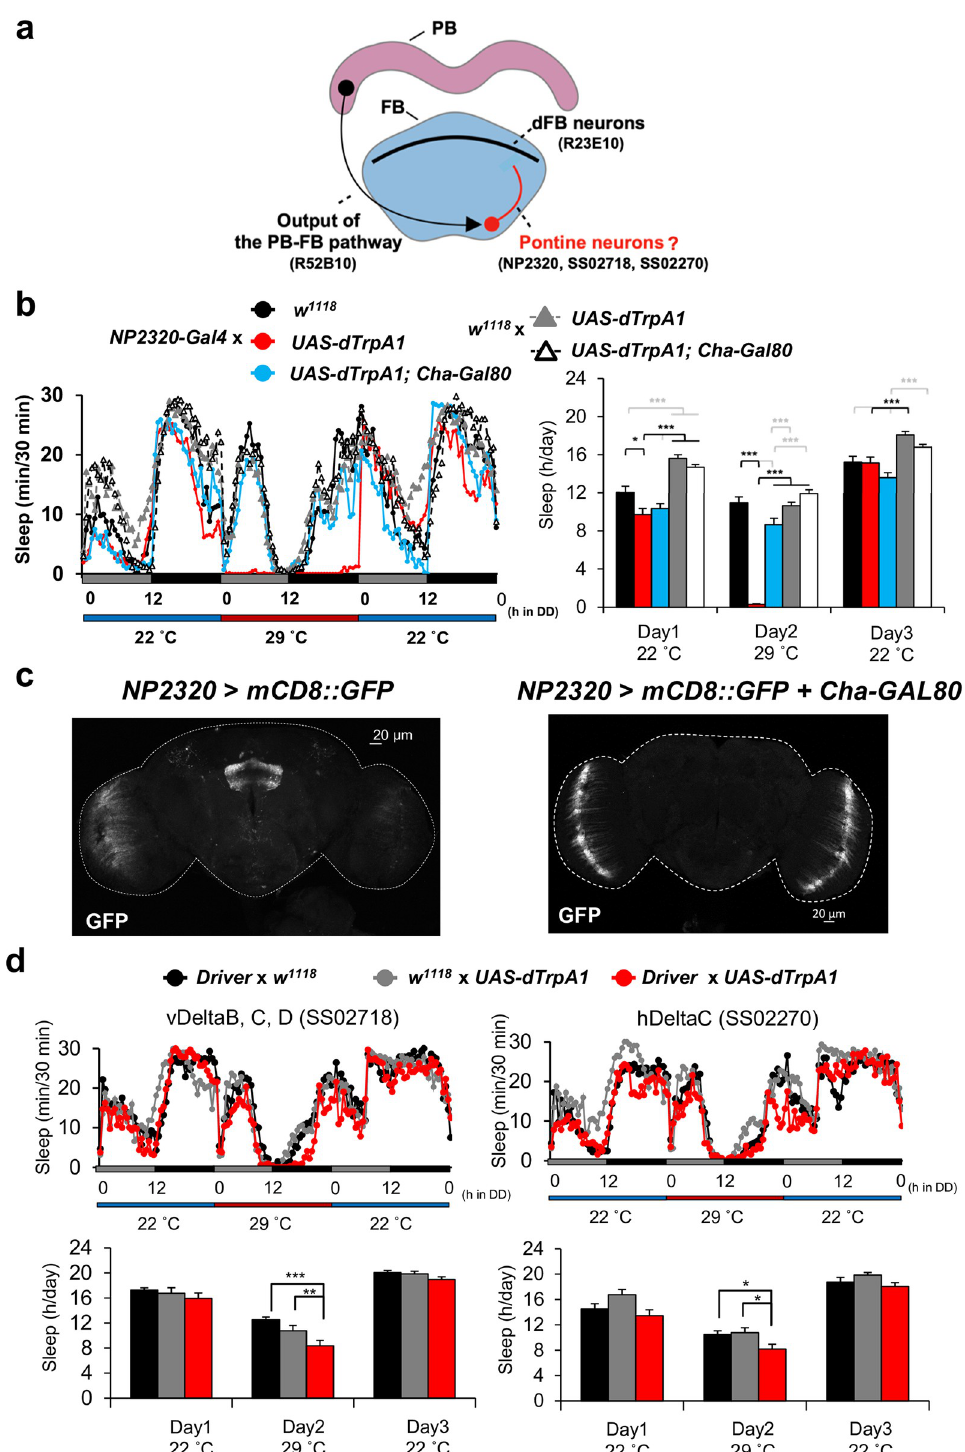
Fig 1. Cholinergic FB interneurons promote arousal. (a) Schematic diagram of the hypothesis of the sleep-regulatory circuit. The names of driver lines are described in the parentheses. (b) right: Sleep profile of each genotype (n = 20, 32, 21, 32, 32 respectively). Thermo-genetic activation by dTrpA1 occurs at 29 ˚C but not at 22 ˚C. left: Quantification of the sleep time. Data are presented as mean + SEM. one-way ANOVA with a Tukey-Kramer HSD test was used. � P < 0.05, �� P < 0.01, ��� P < 0.001 (c) GFP expression pattern of NP2320-Gal4 with and without Cha-Gal80 . (d) top: Sleep profile of